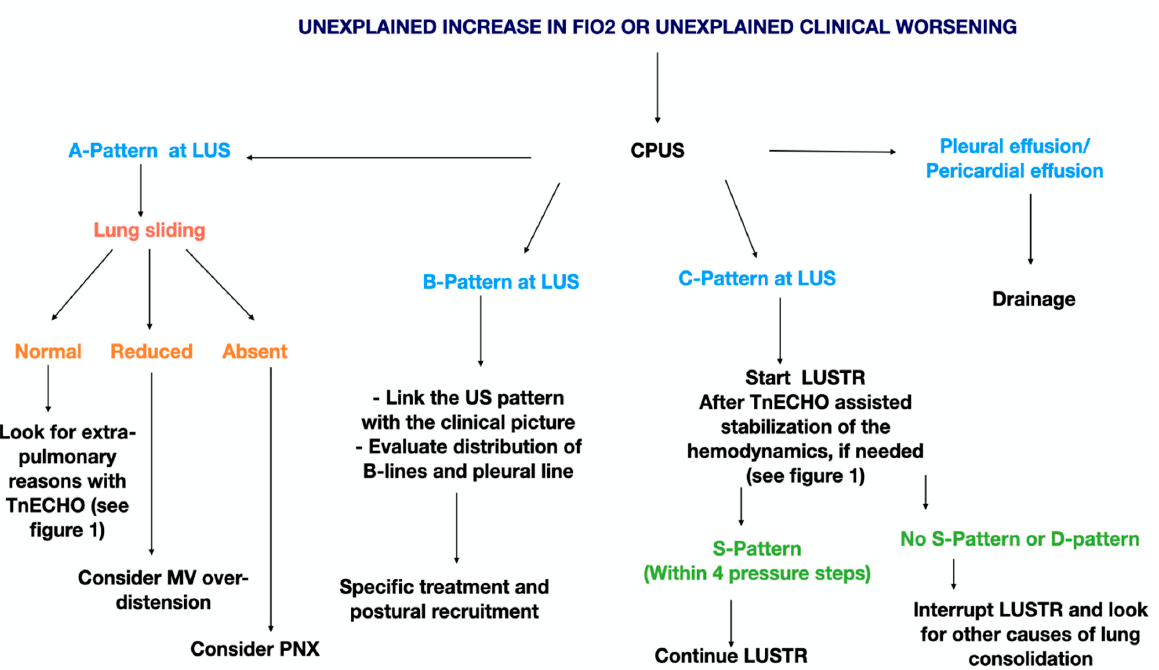
Figure 6. Cardiopulmonary ultrasound (CPUS) guided approach to the deteriorating sick infant. Abbreviations: fraction of inspired oxygen (FiO 2 ), lung ultrasound (LUS), targeted neonatal echocardiography (TnECHO), lung ultrasound targeted recruitment (LUSTR), mechanical ventilation (MV), pneumothorax (PNX).